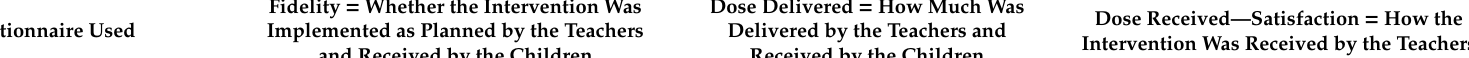
Table 1. Overview of the process evaluation questions to calculate the process evaluation score (score on 24) for teachers. Questionnaire